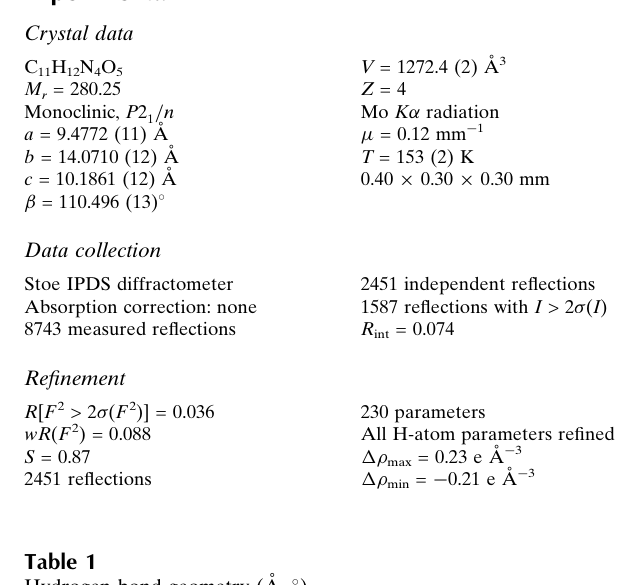
Hydrogen-bond geometry (A˚ , (cid:1)